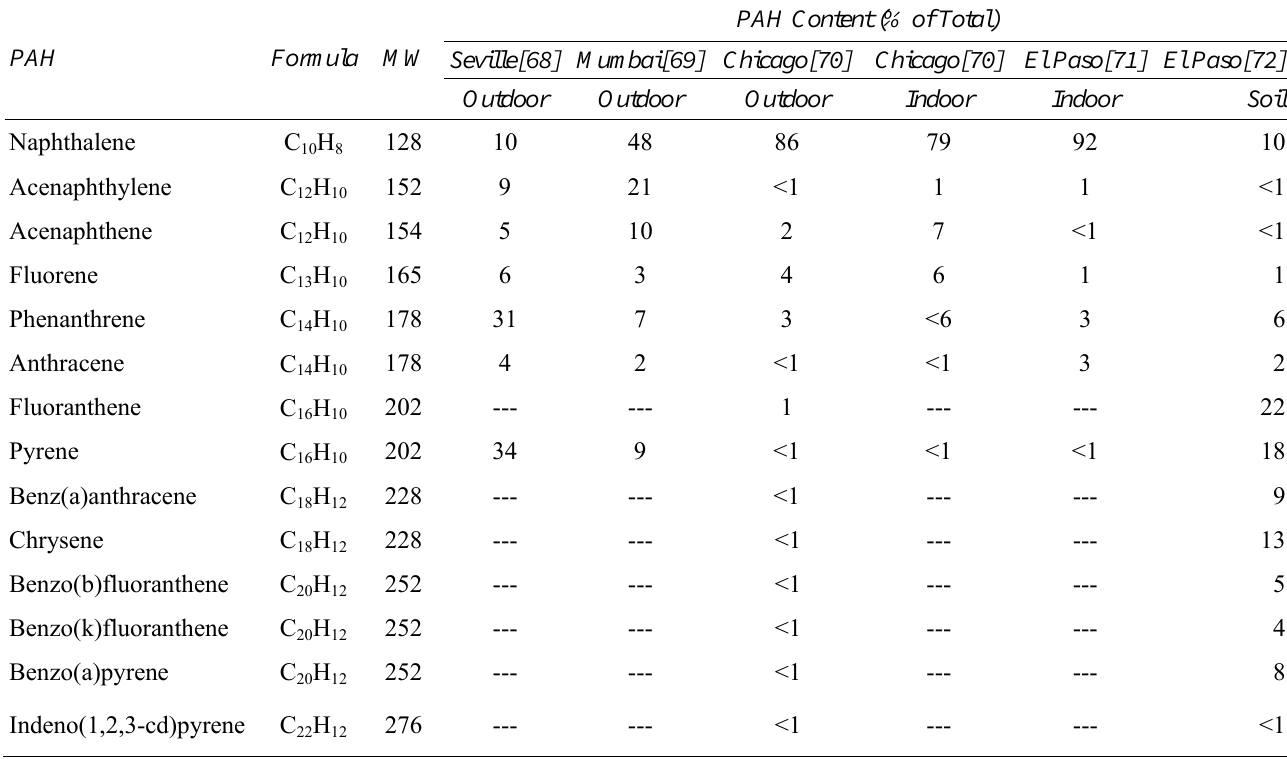
in World cities and in El Paso, Texas (USA) soil. 2.5